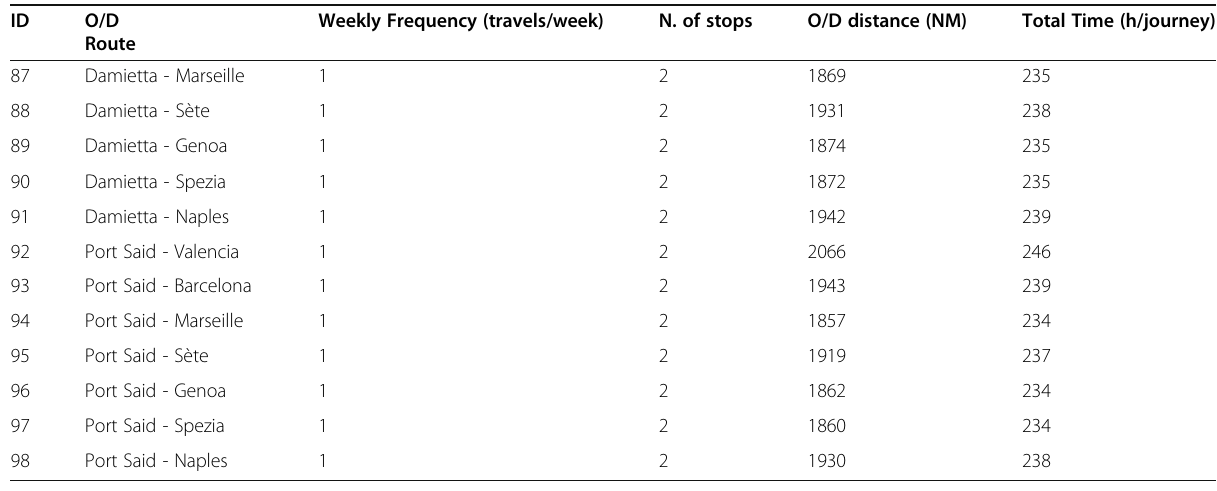
Table 23 Operational features of the optimized network